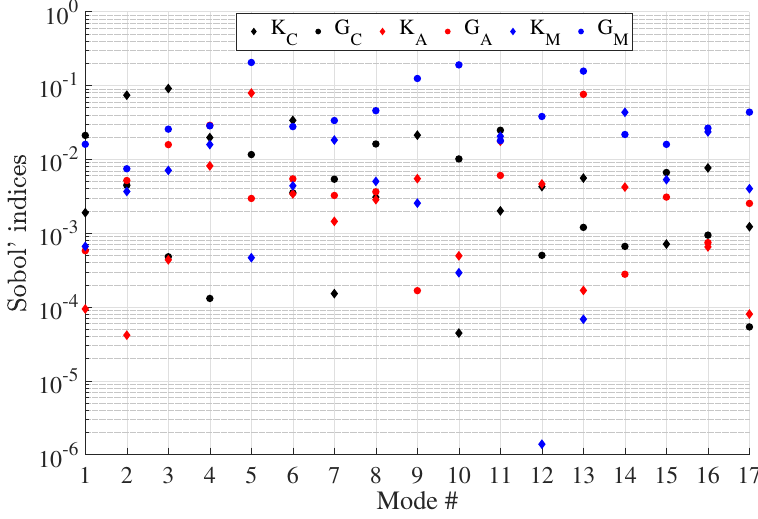
Figure 7. Sobol’ indices for the modal